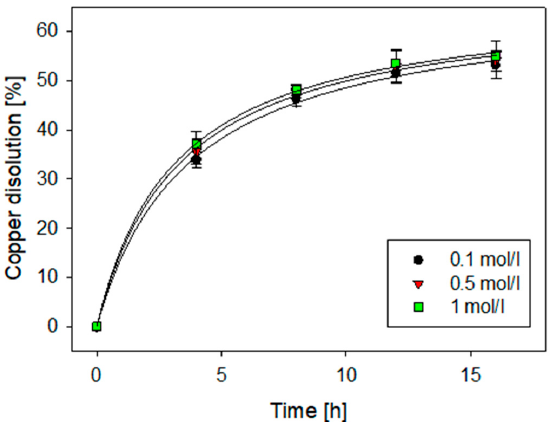
Figure 5. Linear effect graph for the extraction of Cu from chalcocite in a chloride medium [13].